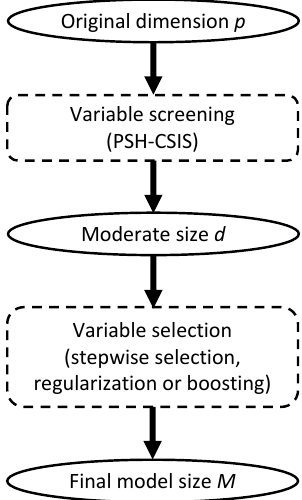
Figure 1. Overall diagram of variable screening and selection.